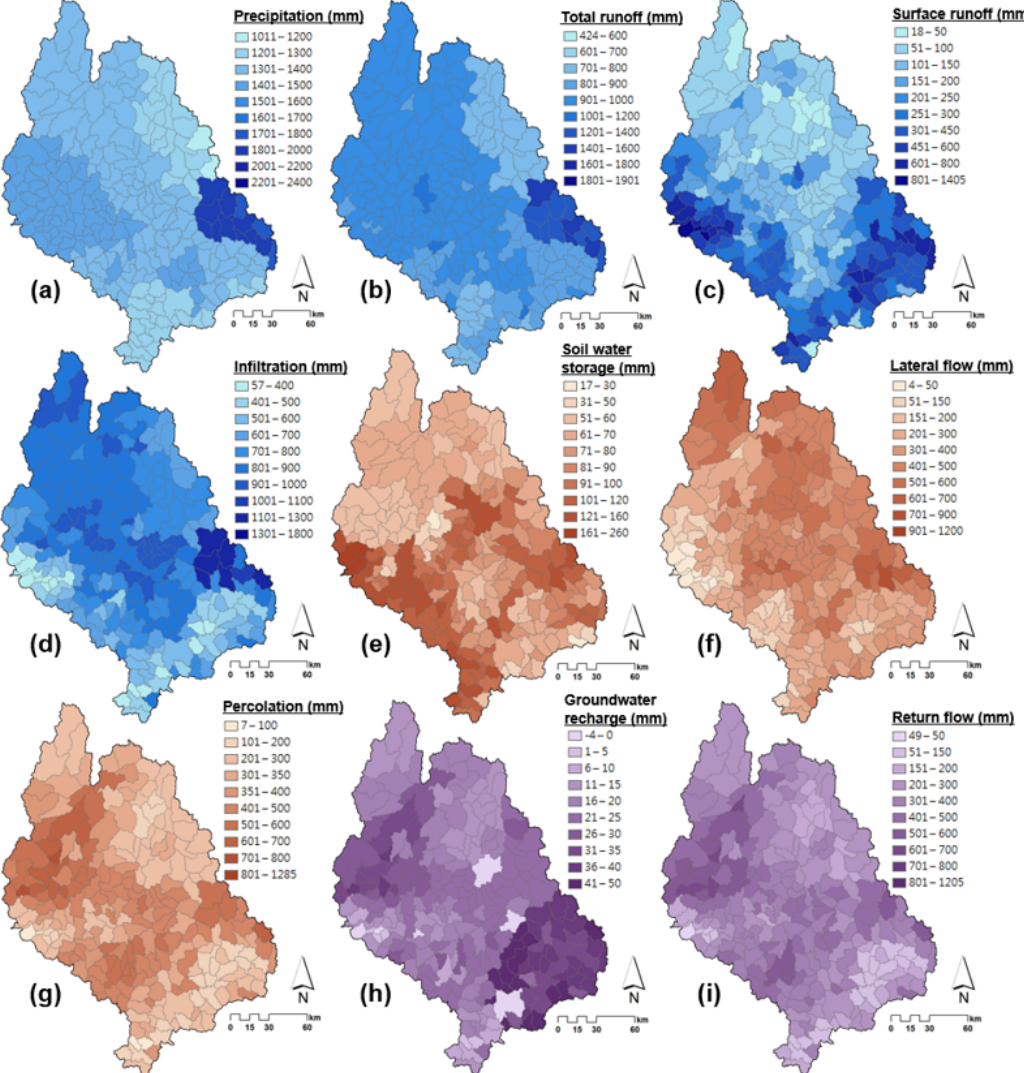
Figure 5. Hydrologic condition for the (a) precipitation, (b) total runoff, (c) surface runoff, (d) infiltration, (e) soil water storage, (f) lateral flow, (g) percolation, (h) groundwater recharge, and (i) return flow according to the hydrological (SWAT) modeling for the period from 1985 to 2014 in the Han River